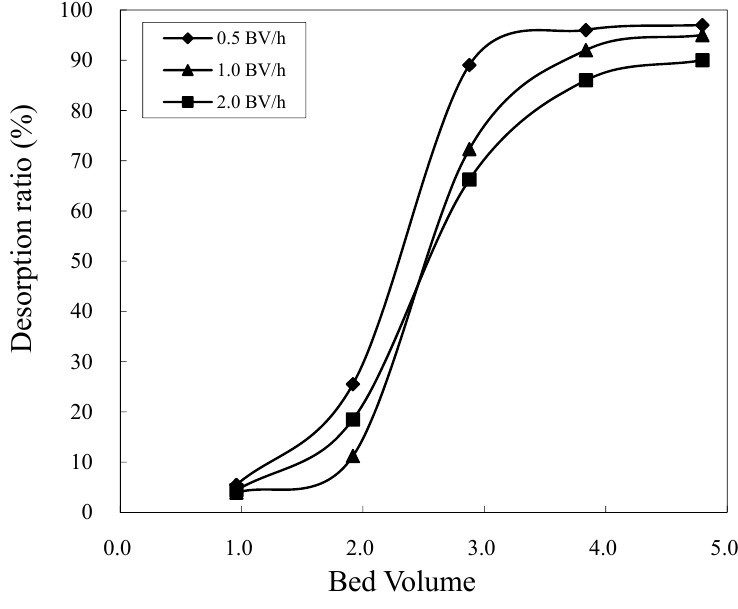
Figure 6. The effect of flow rate on desorption ratio.